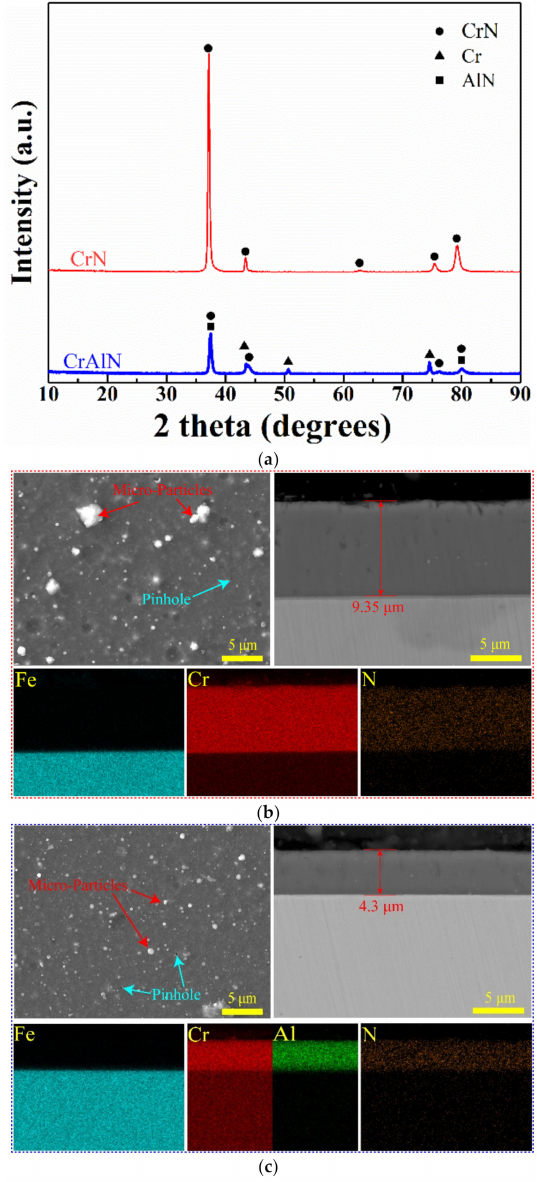
Figure 3. Characterization of coating properties. ( a ) XRD diffraction spectrum of coating samples, ( b ) surface and cross-sectional morphologies and element distribution of CrN, and ( c ) surface and cross-sectional morphologies and element distribution of